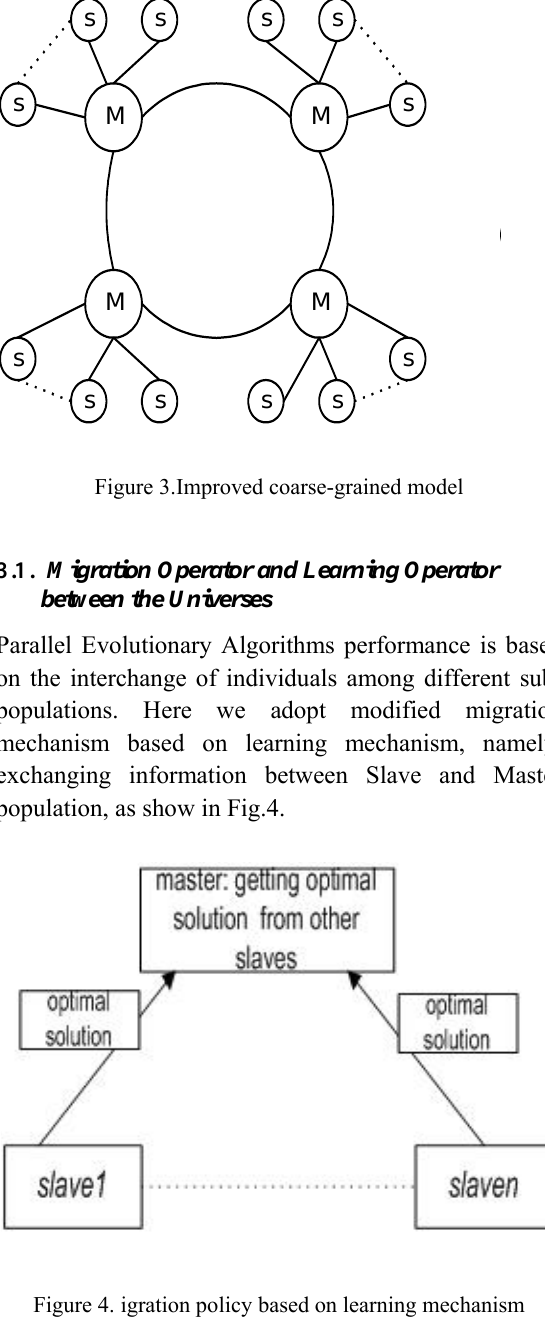
Figure 4. igration policy based on learning